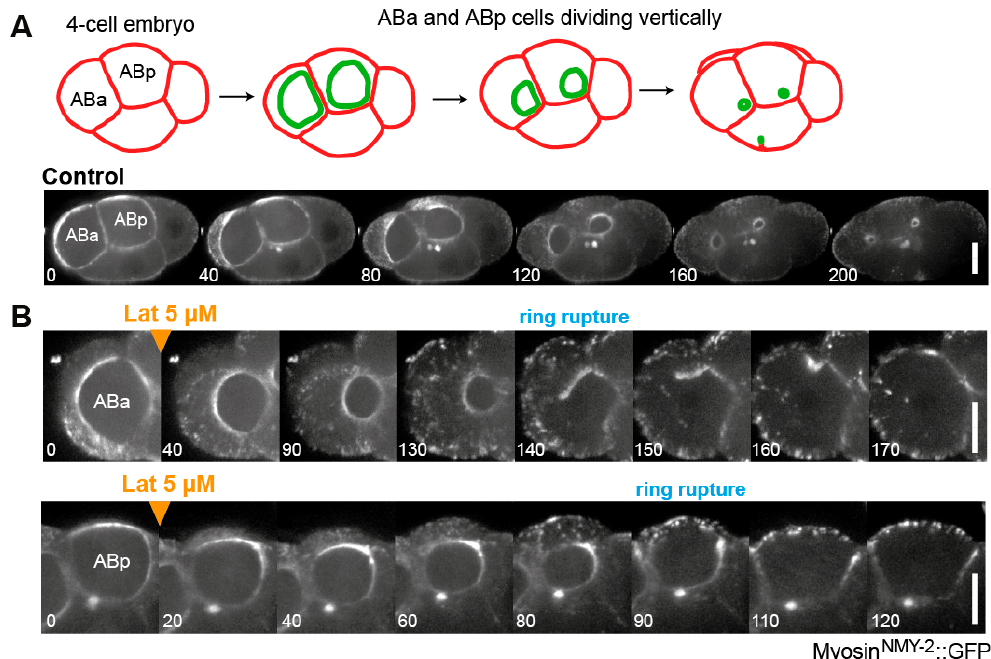
Figure 2. ( A ) Schematic of a 4-cell Caenorhabditis elegans embryo depicting the position of the ABa and ABp cells, whose division occurs perpendicularly to the imaging plane therefore providing the visualization of the entire circumference of the constricting ring (top). Stills of a timelapse video of a 4-cell embryo expressing myosinNMY-2::GFP, where both ABa and ABp rings are undergoing constriction (bottom). Time is in seconds and zero corresponds to the beginning of ring constriction. ( B ) Still images of a timelapse video of a dividing ABa (top) or ABp cell (bottom). Addition of 5 µ M Latrunculin A (orange arrowheads) leads to ring rupture and cytokinesis failure in both cells. Time is in seconds and zero corresponds to frame before drug addition. Scale bars, 10 µ